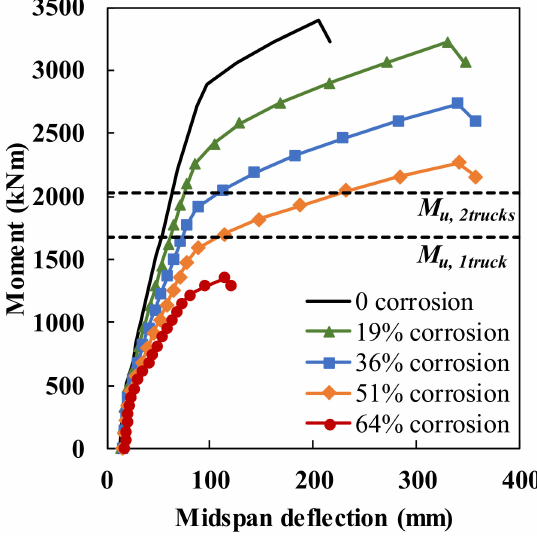
Figure 10. The moment vs midspan deflection of Beam 6 under various corrosion